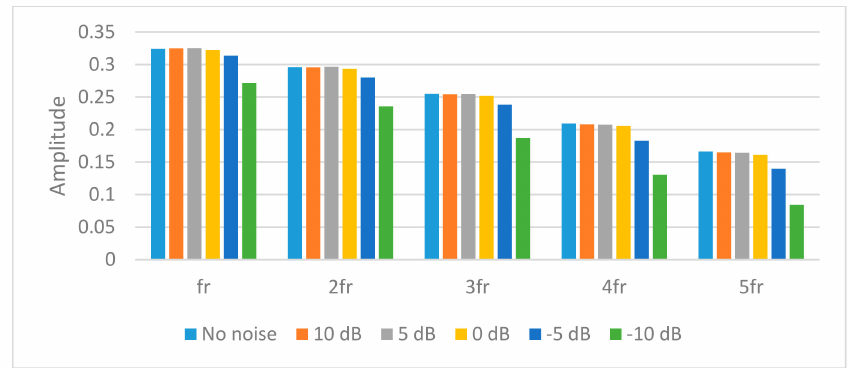
Figure 12. The comparison results for di ff erent noise